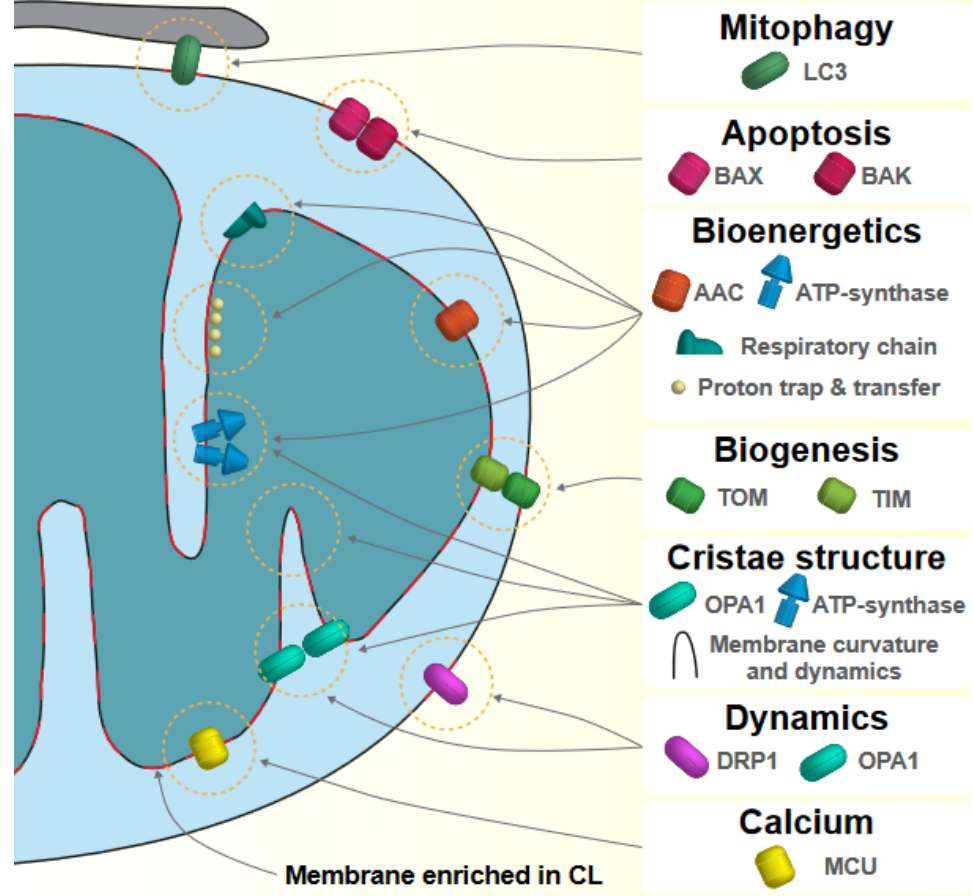
Figure 1. Main processes and proteins regulated by cardiolipin. Mitophagy and apoptosis —Translo- cation of cardiolipin (CL) to the mitochondrial outer membrane is involved in signaling the